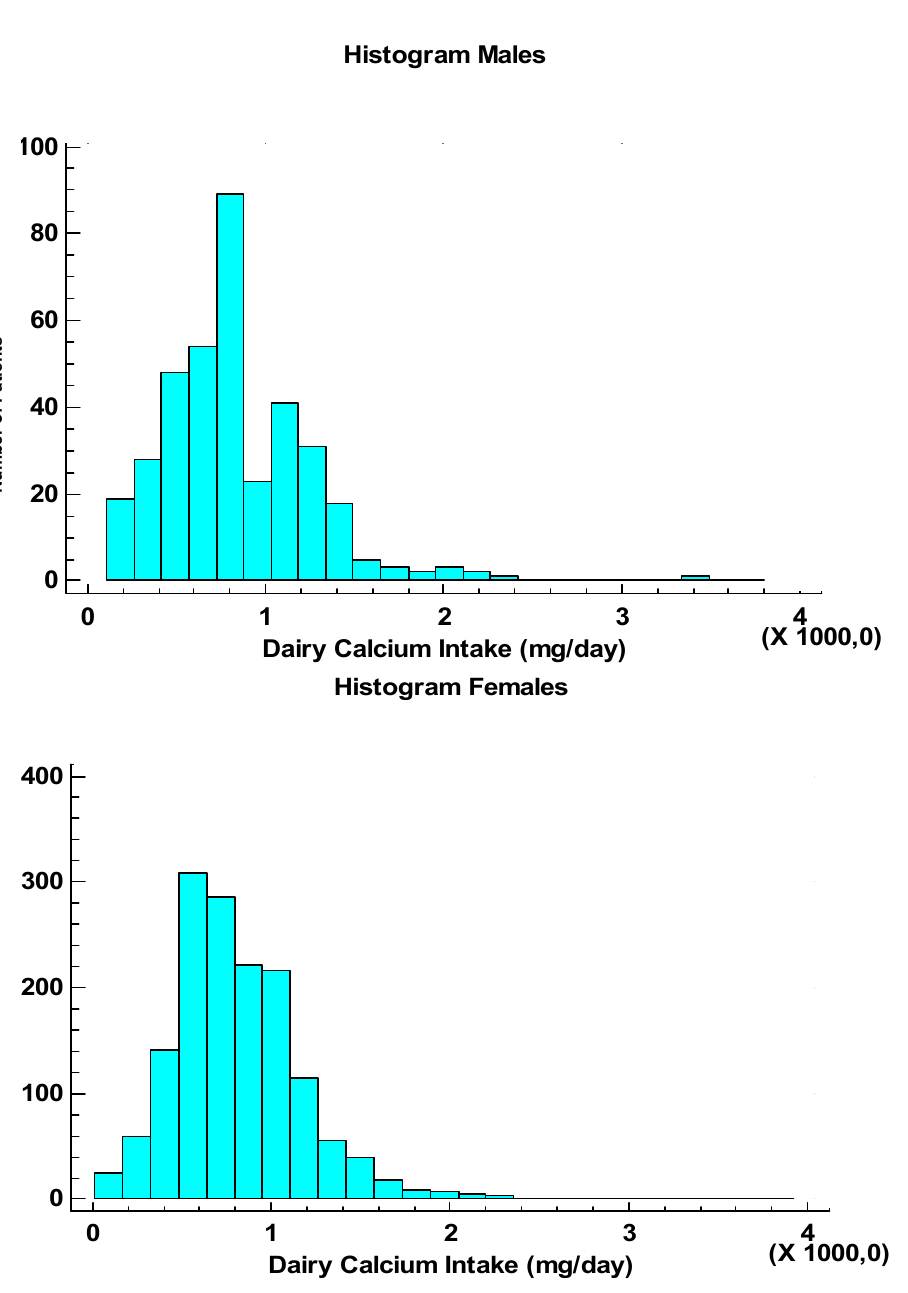
Figure 1. Distributions of daily calcium intake (mg/day) from dairy products in women and